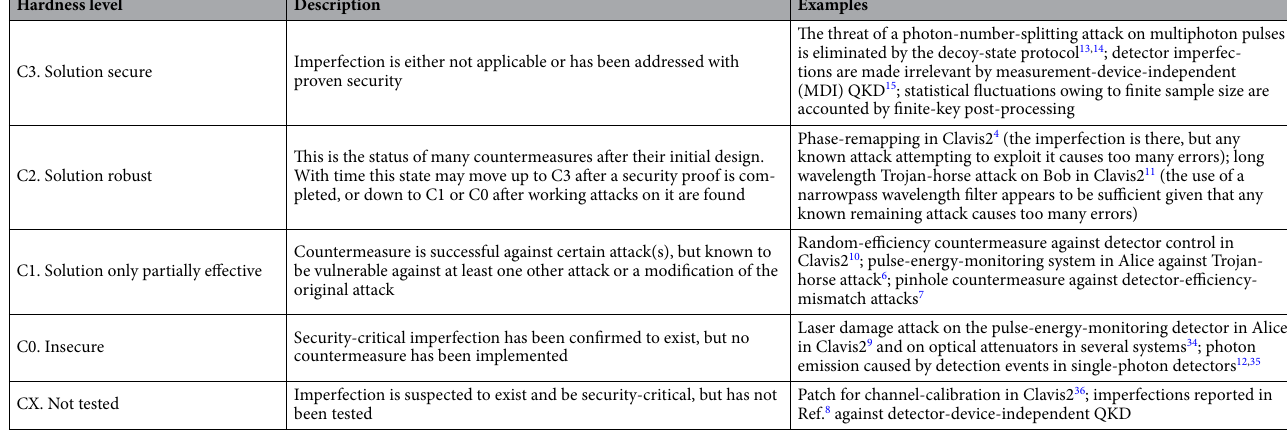
Table 2. Hardness against implementation imperfections. Here we propose a classification scheme quantifying how robust a given system or countermeasure is against a given imperfection. The hardness level is assigned to each particular imperfection and the same imperfection at different systems may be assigned different levels. For each imperfection the hardness level reflects current knowledge, and may change over